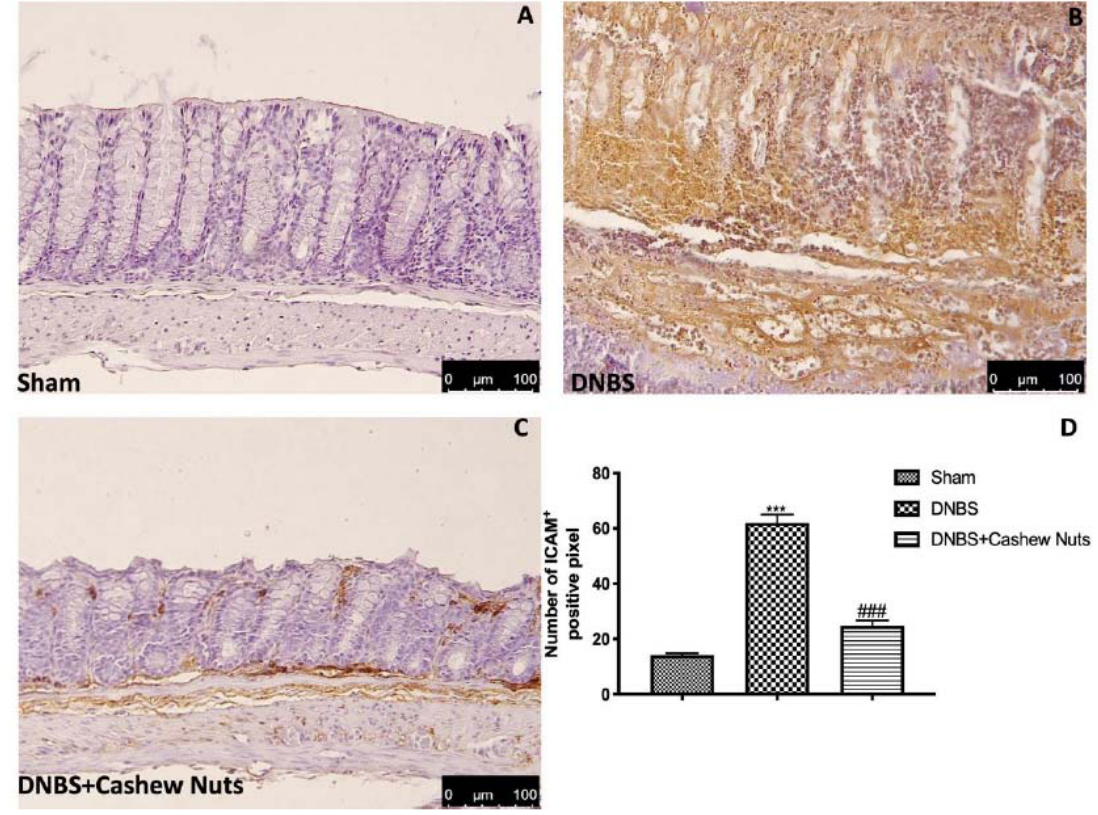
Figure 8. The e ff ects of cashew nuts on ICAM-1 expression after DNBS injection. Immunohistochemistry for ICAM-1 was evaluated in sham ( A ), DNBS ( B ), DNBS + cashew nuts ( C ). The results are expressed as % of positive pixels ( D ). Images are figurative of at least three independent experiments. Values = means ± SEM of six animals in each group; *** p < 0.001 vs. sham; ### p < 0.001 vs.